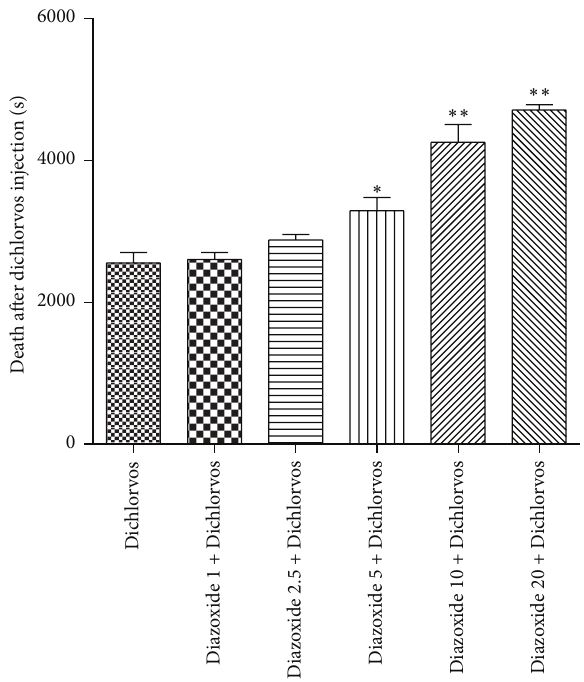
Figure 2: Effect of different doses of Diazoxide (mg/kg) on genera- tion time of death after Dichlorvos injection (50mg/kg) (second). Data are shown as mean ± SEM. ∗ 𝑃 < 0.05 and ∗∗ 𝑃 < 0.001 compared with Dichlorvos group. ( 𝑛 = 10 ).